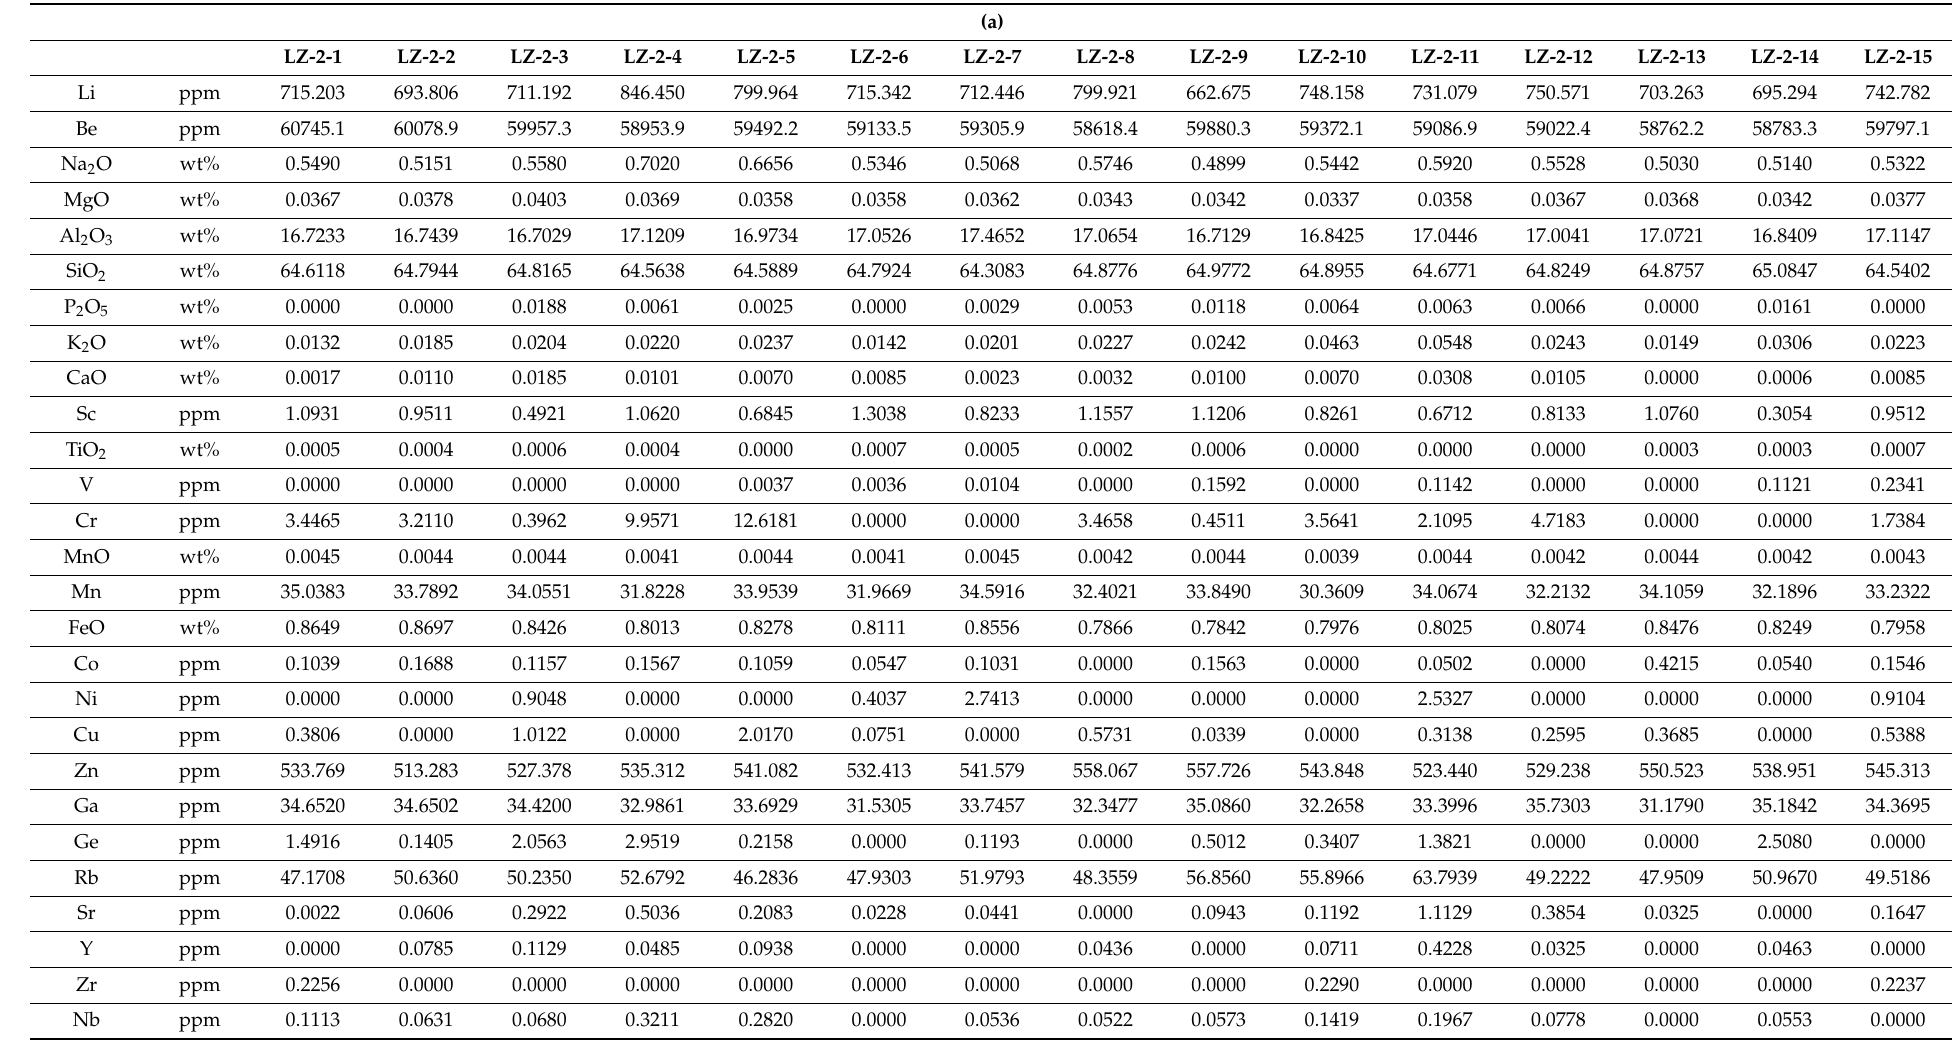
Table A2. Chemical compositions with the structural formulas of aquamarine and tourmalines from Longzi occurrence analyzed by